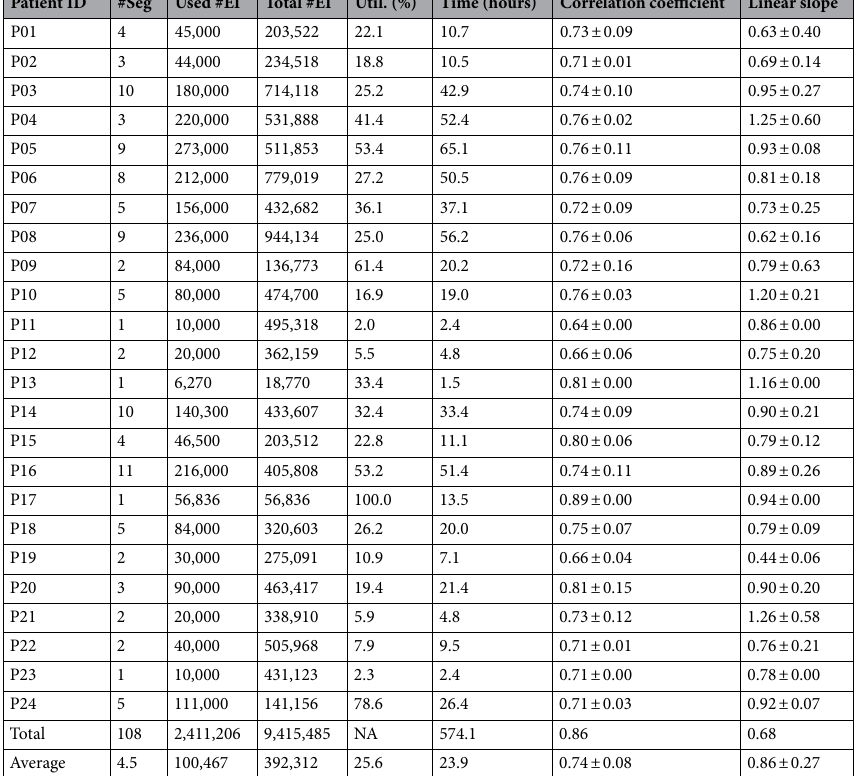
Table 2. List of measured patients (P01–P24) and analysis results. #Seg.: number of used continuous segments, each segment is composed of at least 5 000 sequential EIs; Used #EI: total number of EIs summed over used segments; Total #EI: total number of all recorded EIs; Util.: Used #EI/Total #EI ratio in %; Time: approximate duration (hours) of used segments for average heart rate of 70 bpm; Corr.Coef.: Pearson’s correlation coefficient between selected k 1 (t) and dICP maxima bands in used segments; Lin.Slope: linear regression slope in used